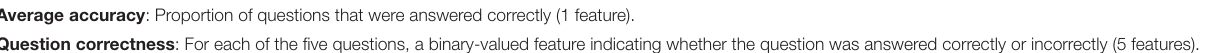
TABLE 5 | Comprehension features (11